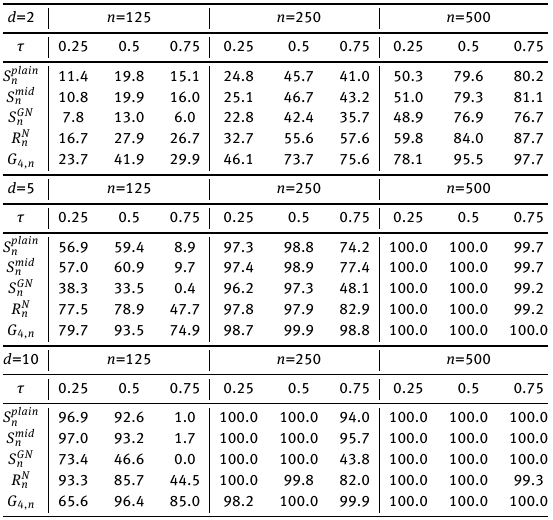
Table 10: Percentages of rejection at a 5% significance level, as estimated from 1000 replicates, for the tests based on S plain n , S mid n , S GN n , R N n and G 4, n under the Gumbel copula.